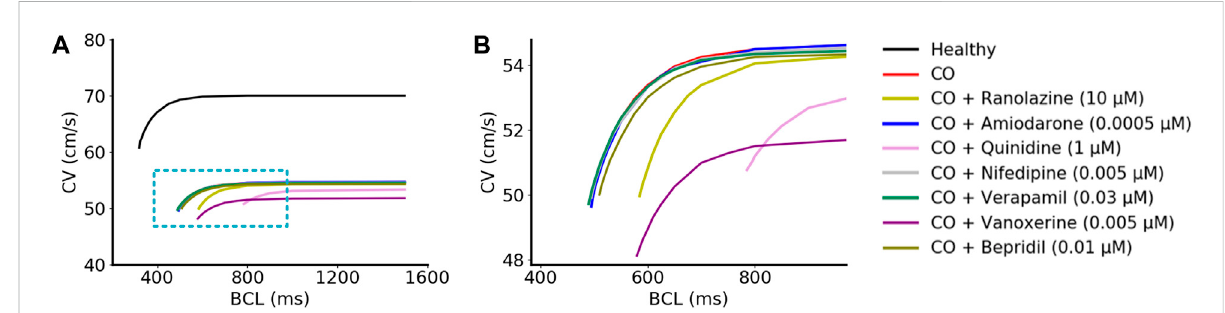
FIGURE 7 SimulatedCVrestitutioncurvesindifferentconditions. (A) CVrestitutioncurvesunder ‘ healthy ’ , ‘ CO ’ ,and ‘ CO+drug ’ conditions.Themagni fi ed view inside the blue rectangle was shown in (B)